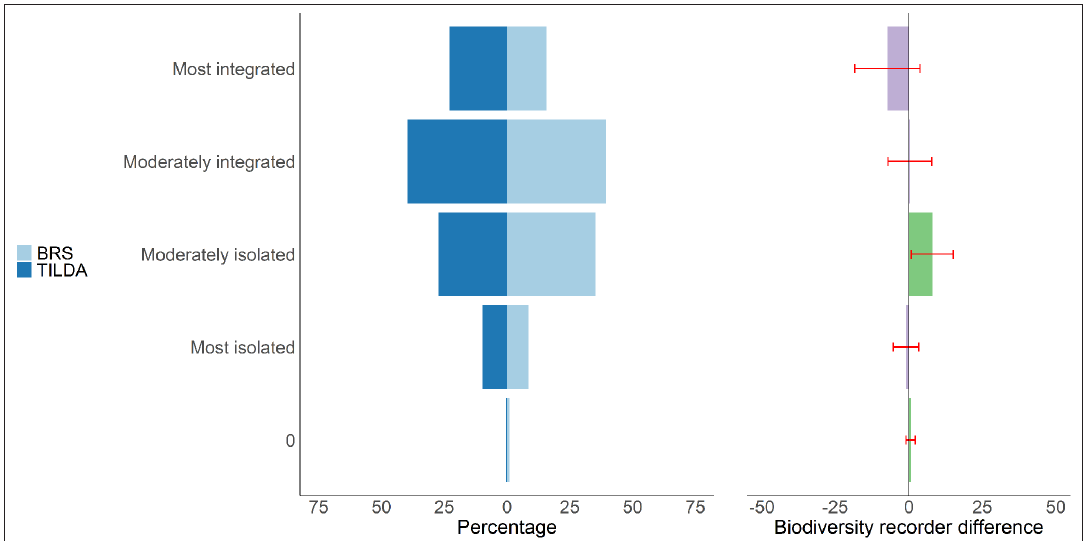
Figure 7: Berkman-Syme Social Network Index distribution of biodiversity recorders compared with that of older adult population in Ireland using The Irish Longitudinal Study on Ageing (TILDA). Note that 95% confidence intervals are based on difference in proportions